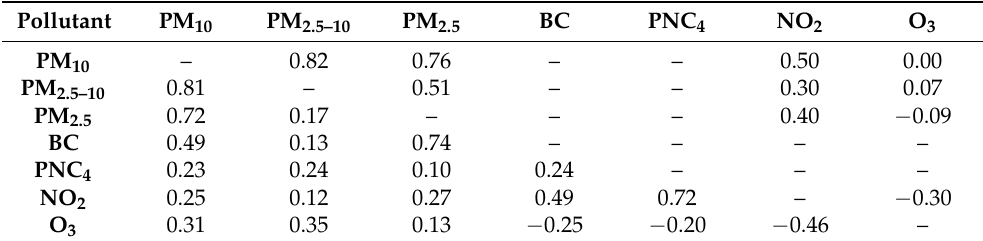
Table 3. Correlation matrix with R-values (Pearson correlation coefficients) between the different air pollutants measured in Stockholm during the period from 2000 to 2016, and in Tallinn during the period from 2001 to 2018. Correlations for Stockholm are to the left of and below the diagonal from the top left to the bottom right. Correlations for Tallinn are to the right of and above the diagonal from the top left to the bottom